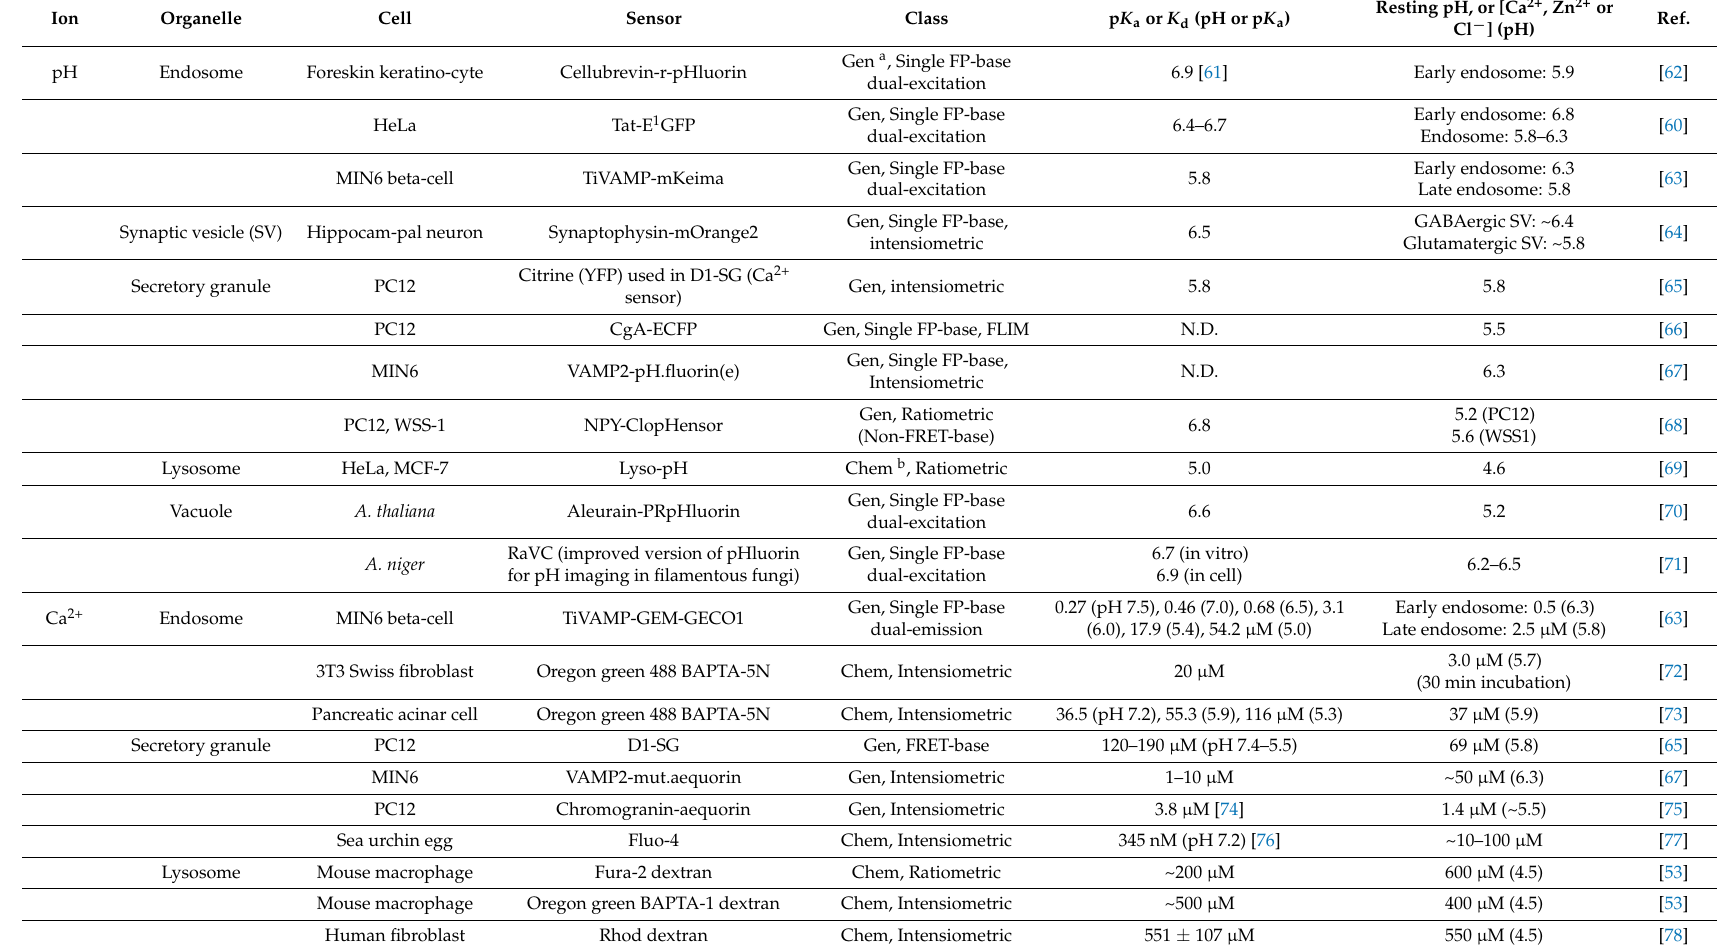
Table 2. FP-based or chemical dye-based sensors for measurement of ion concentration in acidic